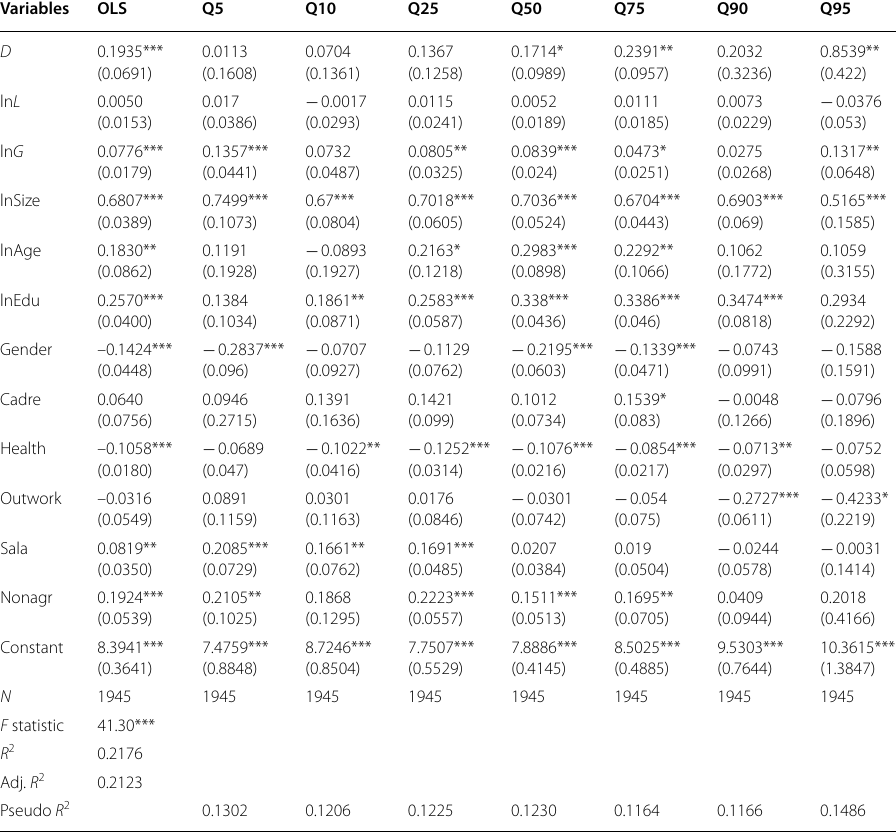
Table 2 Estimation results of the OLS and quantile